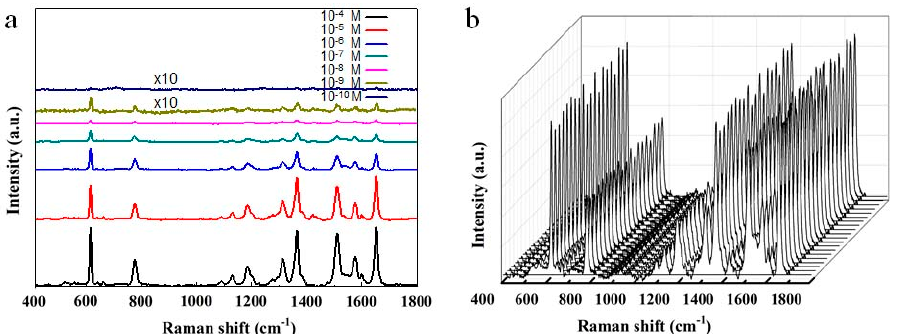
Figure 4. ( a ) Raman spectra of R6G with the concentrations of 10 − 4 , 10 − 5 , 10 − 6 , 10 − 7 , 10 − 8 , 10 − 9 , and 10 − 10 mol/L on the Ag/3D-TiO 2 /Si substrate. (The signal is expanded 10 times at the R6G concentration of 10 − 9 and 10 − 10 mol/L.); ( b ) Raman spectra of R6G with the concentration of 10 − 4 mol/L adsorbed at 20 random points of the Ag/3D-TiO 2 /Si substrate.